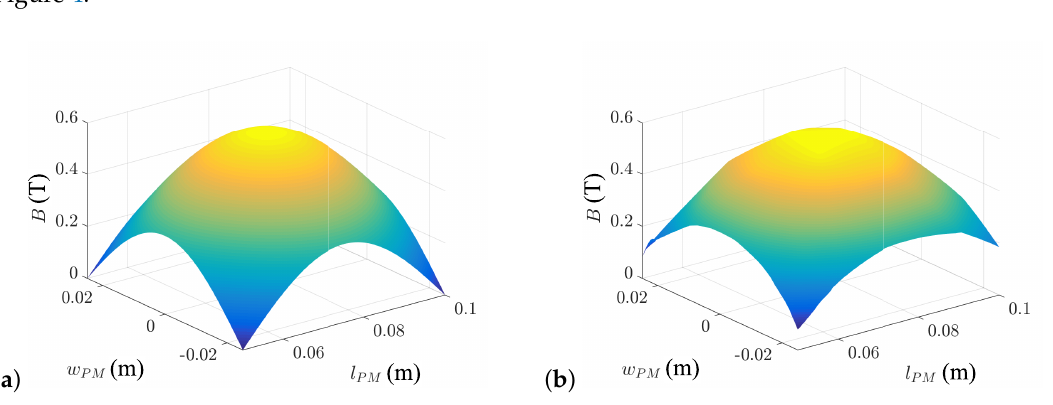
Figure 4. Normal component air gap flux distribution from two permanent magnets in the middle of the coreless armature, ( a ) calculated value based on the assumption expressed by Equation (6); ( b ) finite element method (FEM) simulation